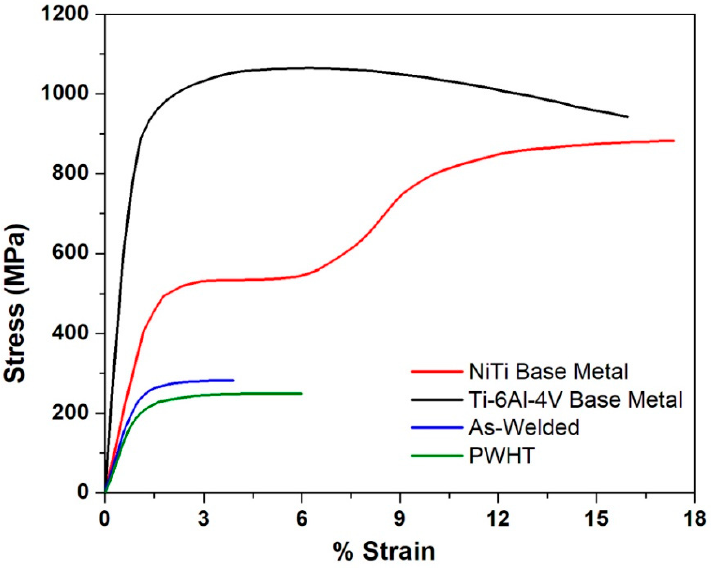
Figure 11. The typical tensile properties of base metals and dissimilar Ti-6Al-4V/Nitinol friction lin- ear friction welds in the as-welded and PWHT conditions.